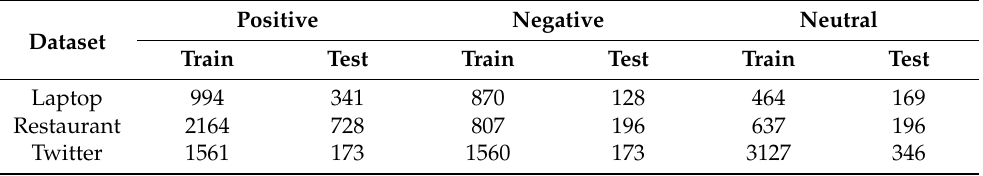
Table 1. Experimental data statistics.